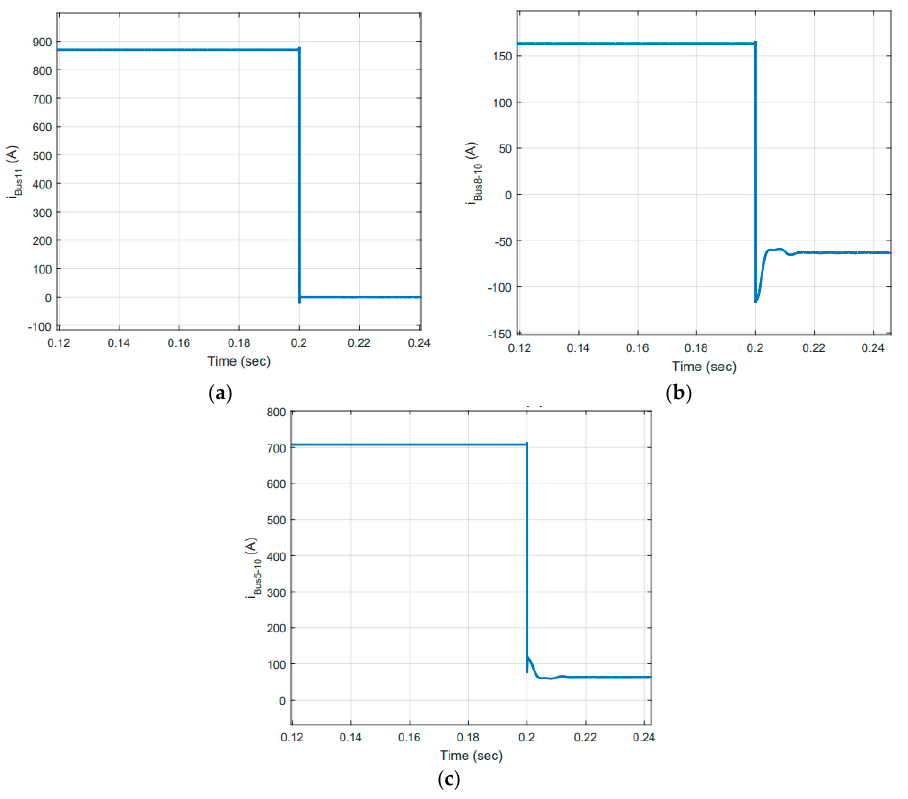
Figure 13. Currents during the fault occurring at bus 11, ( a ) current waveform of bus 11, ( b ) current waveform of bus 8 to bus 10, and ( c ) current waveform of bus 5 to bus 10. The same current of the line between bus 5 and bus 10 will pass through the line of bus 10–8. The direction of that current will be opposite its direction before the occurrence of the fault and disconnect 4MW load; Figure 13c shows that current. At that point, the circuit breakers CB17 and CB18 placed on the line between bus 8 and bus 10 should be bi- directional breakers to allow the power to flow from bus 10 to bus 8. Figure 13b shows the line current between bus 8 and bus 10 is changed from its original positive value to the negative. Based on that, the Y-source breakers placed on this line allow the current flow in the opposite direction. In order to test the bi-directional Y-source breaker, a fault will apply at the middle of the line between bus 8 and 10 as represented by point F B as shown in Figure 12. The fault will apply after the current of the line flows in the opposite direction. CBs 17 and 18 will